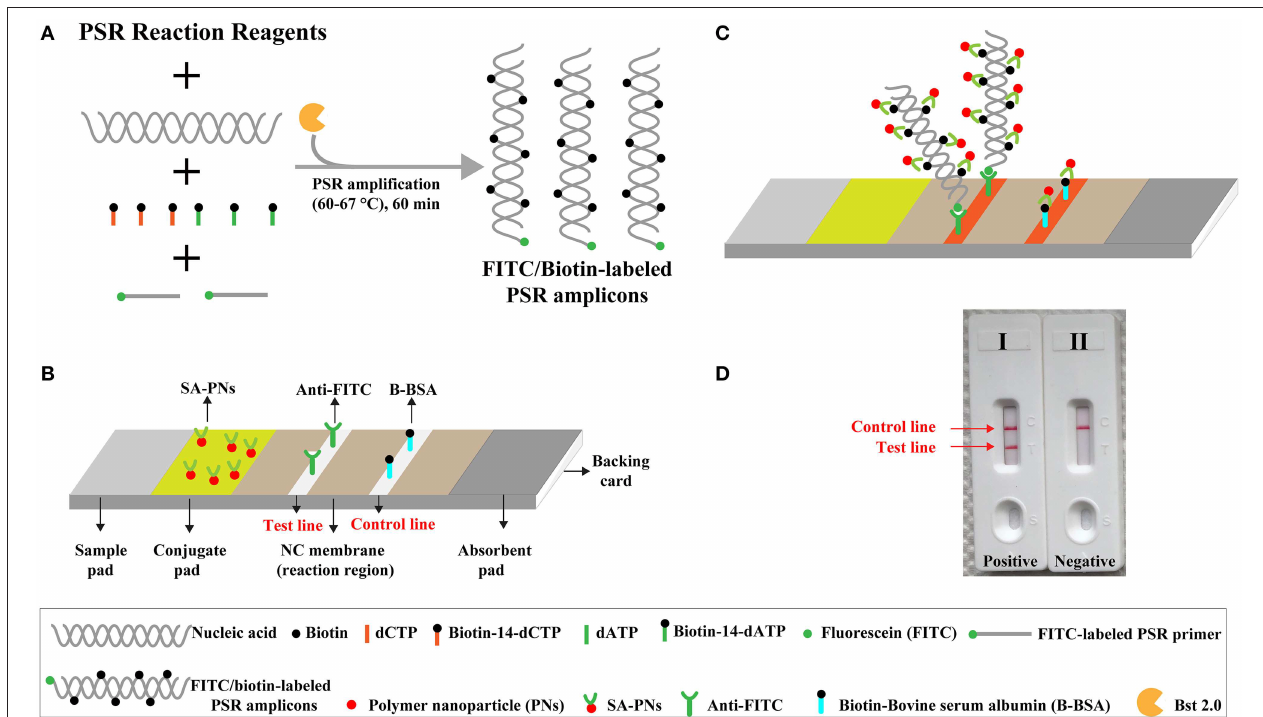
FIGURE 1 | Outline of nanoparticle-based biosensor-supplemented polymerase spiral reaction assay (NB-PSR). (A) Outline of PSR with Ft* primer, biotin-14-dCTP, and biotin-14-dATP. (B) The detailed structure of NB. (C) The schematic illustration of the principle of NB for visualization of PSR products. (D) Interpretation of the results: (I) positive (two red bands, including test line and control line, appeared on the visual region of NB); (II) negative (only the control line region showed a red band).